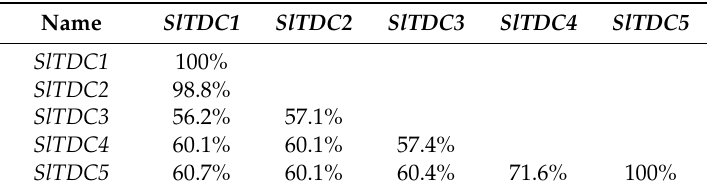
Figure 1. The characterization of the sequence and secondary structure of the SlTrpDC proteins. Multiple sequence alignments were performed using Clustal. The secondary structures were predicted by using a PSIPRED tool. The α-helices and β-loops are denoted with blue. The kinase-specific phosphorylation site was predicted by KinasePhos 2.0 and marked with a red box. Table 2. Identity levels of the SlTrpCD proteins.